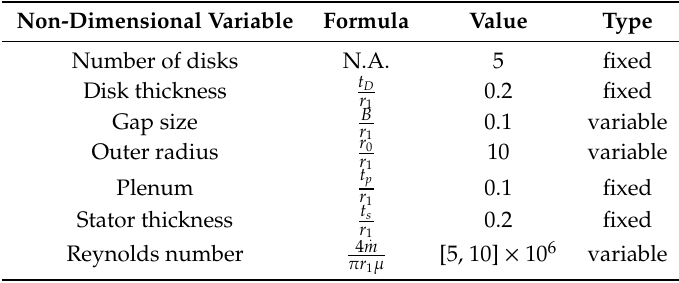
Table 1. Values of design variables.